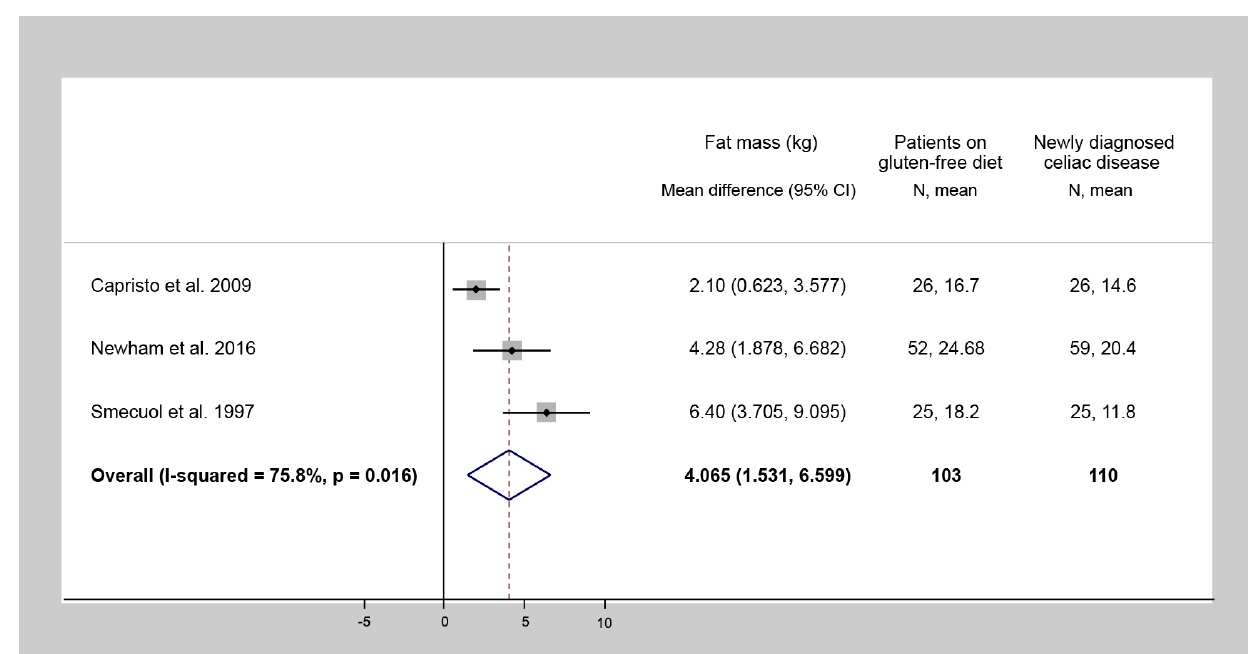
Figure 2. Forest plot of studies comparing fat mass of celiac disease patients after at least a one-year gluten-free diet to that of the same patients at diagnosis (a positive number indicates a gain in fat mass following a gluten-free diet). N: Number of patients.